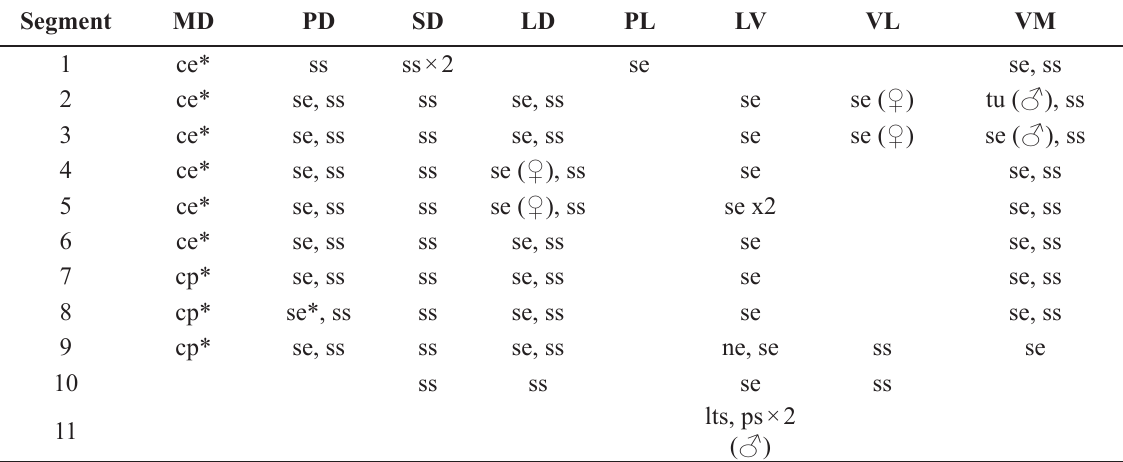
Table 2. Summary of nature and arrangement of cuticular elevations, processes, spines, tubes, setae, sensory spots and nephridiopores in Setaphyes algarvensis sp. nov. Abbreviations: ce = cuticular elevation; cp = cuticular process; LD = laterodorsal; lts = lateral terminal spine; LV = lateroventral; MD = middorsal; ne = nephridiopore; PD = paradorsal; PL = paralateral; ps = penile spine; SD = subdorsal; se = seta; ss = sensory spot; tu = tube; VL = ventrolateral; VM = ventromedial; * = unpaired structures; ♂/♀ indicate sexually dimorphic